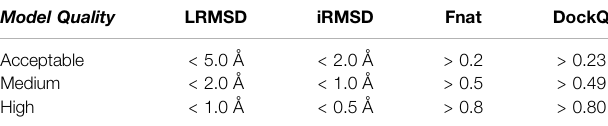
TABLE 1 | CAPRI criteria for peptide-protein docked model quality (Lensink et al., 2017) and the equivalent values in terms of DockQ score (Basu and Wallner, 2016a). iRMSD is the root mean square deviation of residues at the native interface; fnat is the fraction native residue-residue contacts